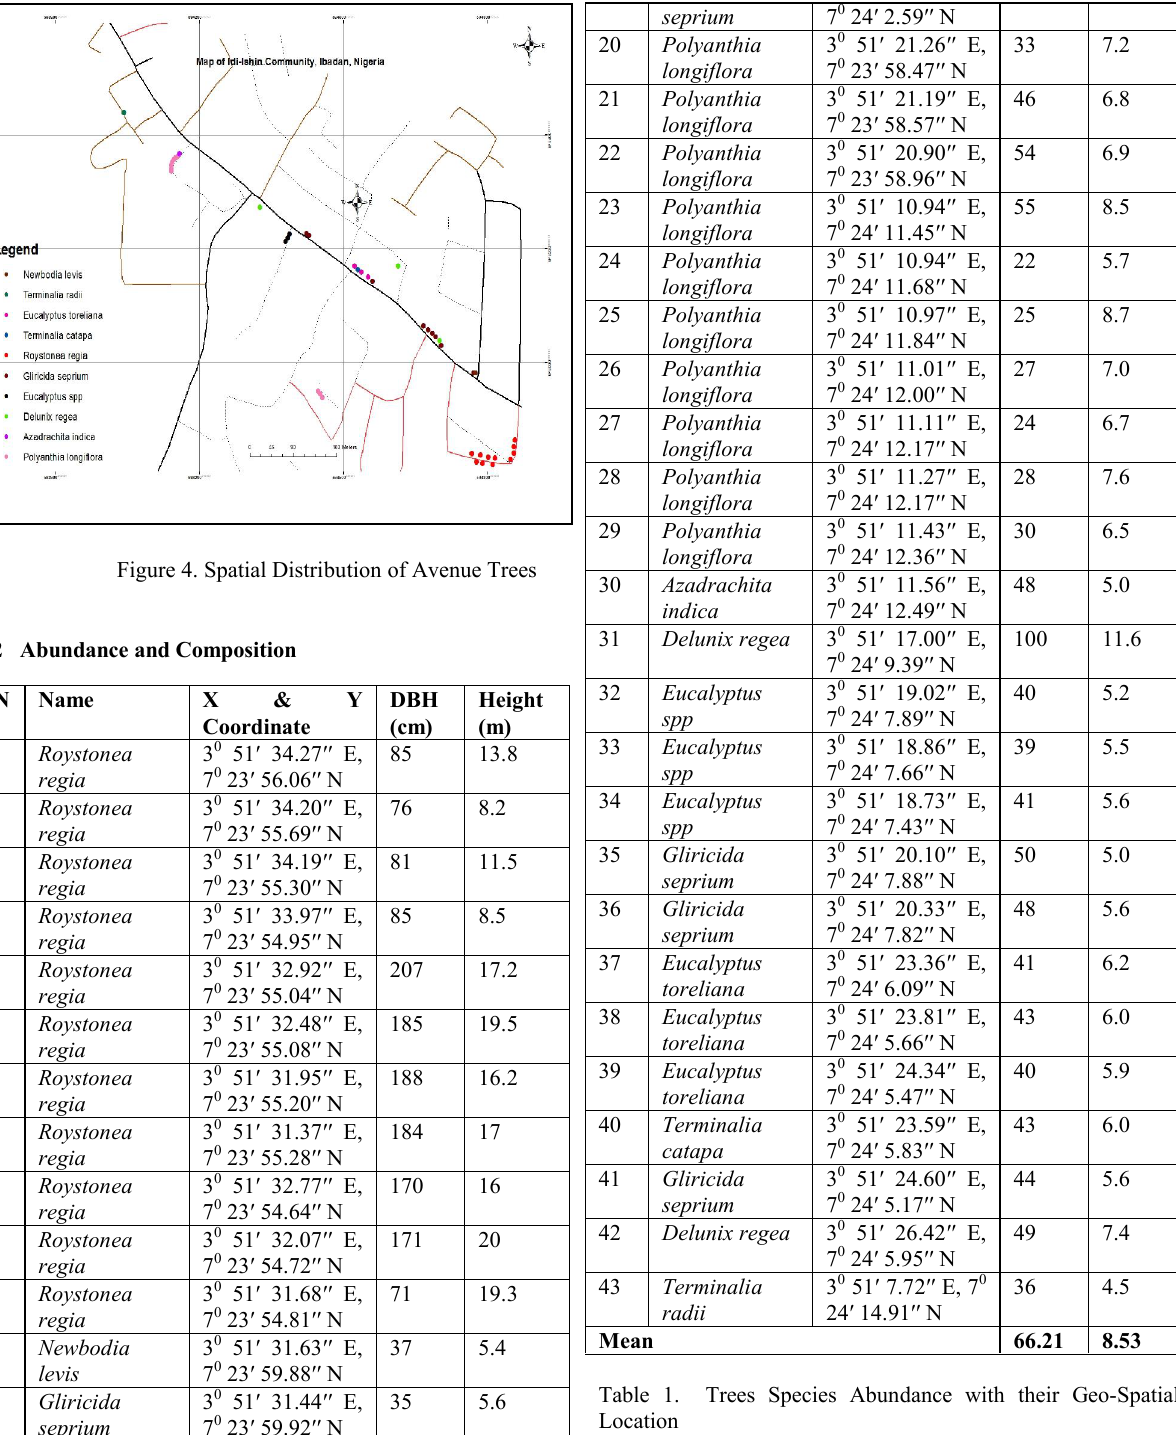
Table 1. Trees Species Abundance with their Geo-Spatial Location Table 1 presents the abundance and geo-spatial location of the tree species encountered. A total number of 43 avenue trees were assessed in Idi-Ishin Community. In terms of the species abundance, Roystonea regia accounted for the majority of the avenue trees (25.58%), followed by Polyanthia longiflora (23.26%), Gliricida seprium (20.93%), Eucalyptus toreliana (13.95%), Delunix regea (6.98%). However Terminalia catapa, Terminalia radii, Azadrachita indica and Newbodia levis had the same abundance of